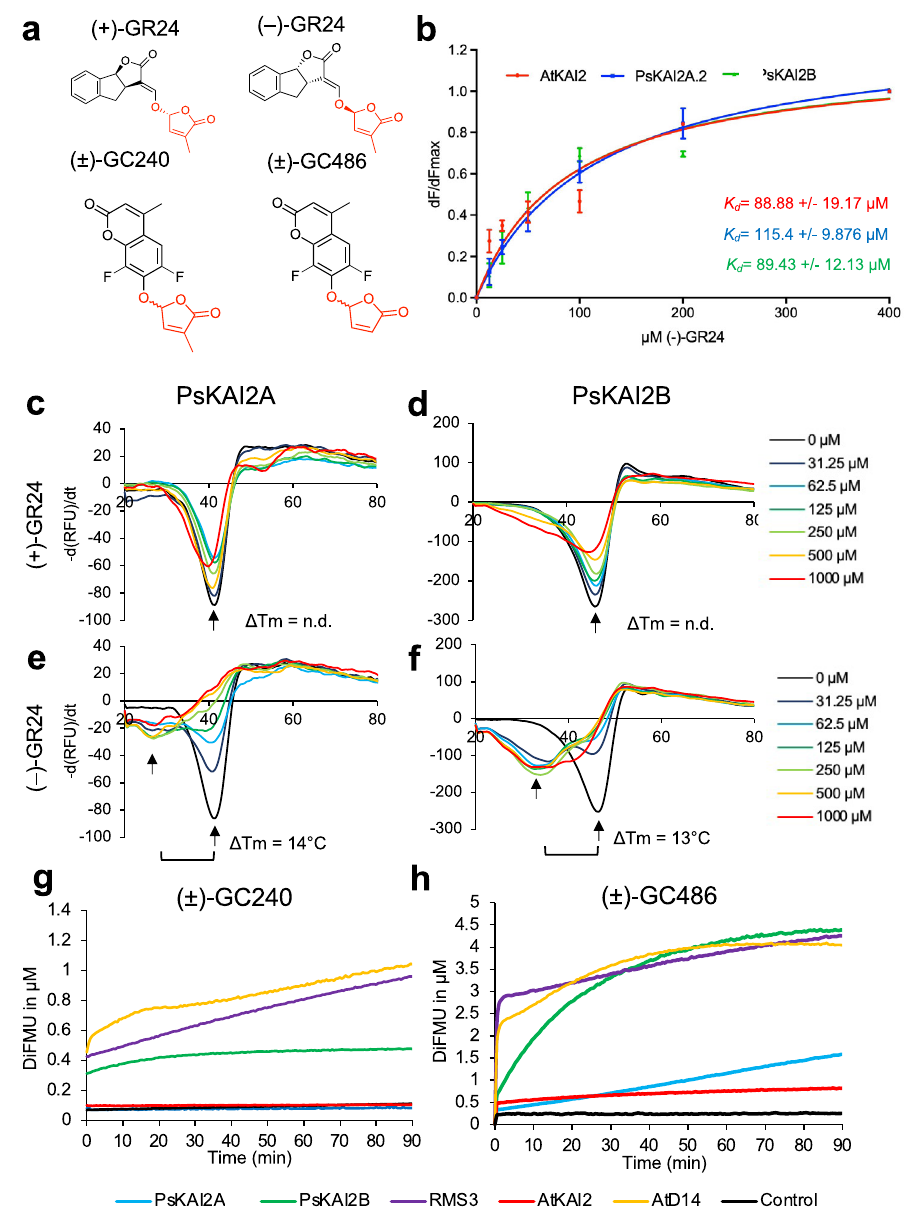
Fig. 4 Biochemical analysis of PsKAI2A and PsKAI2B interactions with different GR24 isomers and enzymatic property. a Chemical structure of ligands used. b Plots of fl uorescence intensity versus SL concentrations. The change in intrinsic fl uorescence of AtKAI2, PsKAI2A and PsKAI2B was monitored (see Supplementary Fig. 9) and used to determine the apparent K d values. The plots represent the mean of two replicates and the experiments were repeated at least three times. The analysis was performed with GraphPad Prism 7.05 Software. DSF assay. The melting temperature curves of 10 µ M PsKAI2A ( c , e ) or PsKAI2B ( d , f ) with ( + )-GR24 ( c , d ), ( – )-GR24 ( e – f ) at varying concentrations are shown as assessed by DSF. Each line represents the average protein melt curve for three technical replicates; the experiment was carried out twice. Enzymatic kinetics for AtD14, AtKAI2, RMS3, PsKAI2A and PsKAI2B proteins incubated with (±)-GC240 ( g ) or (±)-GC486 ( h ). Progress curves during probes hydrolysis, monitored ( λ em 460 nm) at 25 °C. Protein catalyzed hydrolysis with 400 nM µ M of protein and 20 µ M of probes. These traces represent one of the three replicates and the experiments were repeated at least two